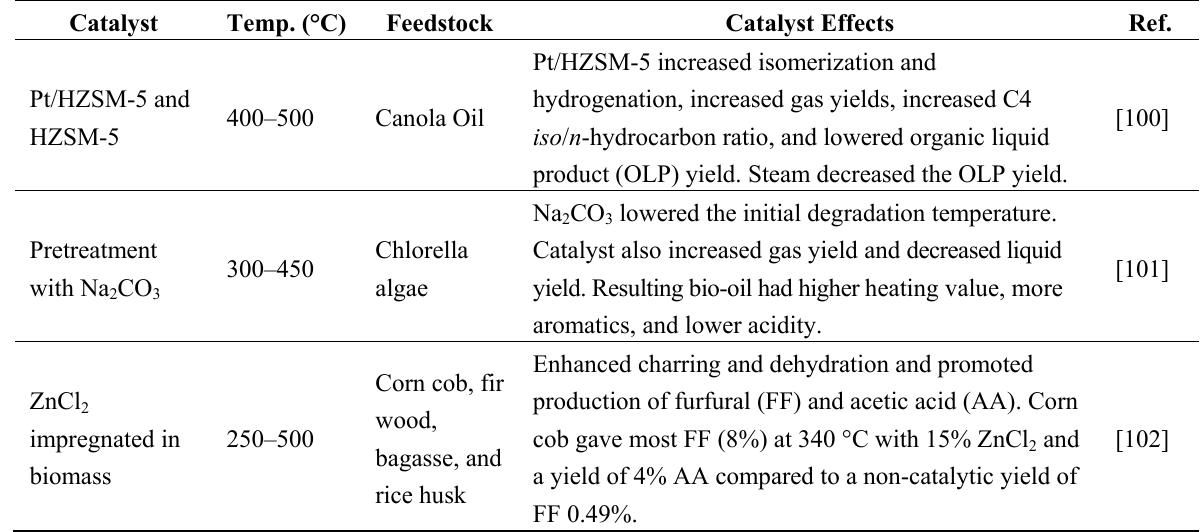
Table 4. Summary of results from current work on HDO, zeolite, multifunctional, and novel